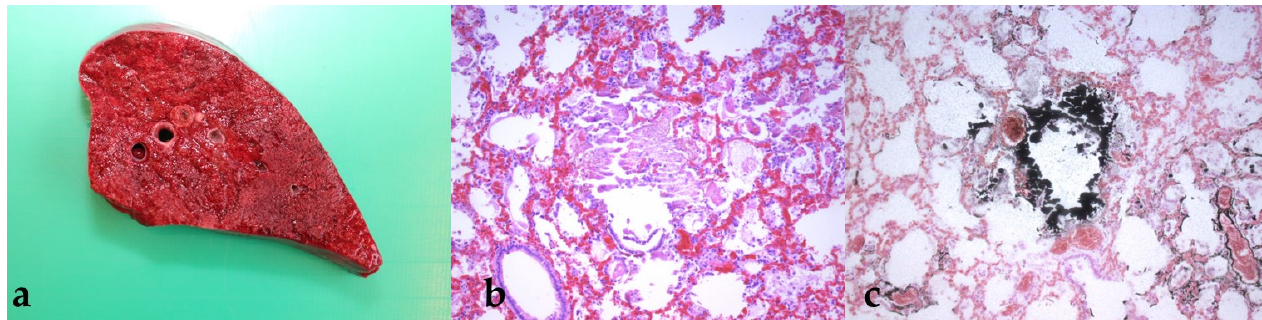
Figure 3. ( a – c ) Liver. The grayish, hard foci in the liver parenchyma show up histologically as large-area mineralization foci (b, H.E. stain; c, von Kossa stain). Moreover, stomach compartment 3 of cria 2 displayed firm, grayish-white mucosal spots, which histologically turned out to be severe mineralization with purulent, partly